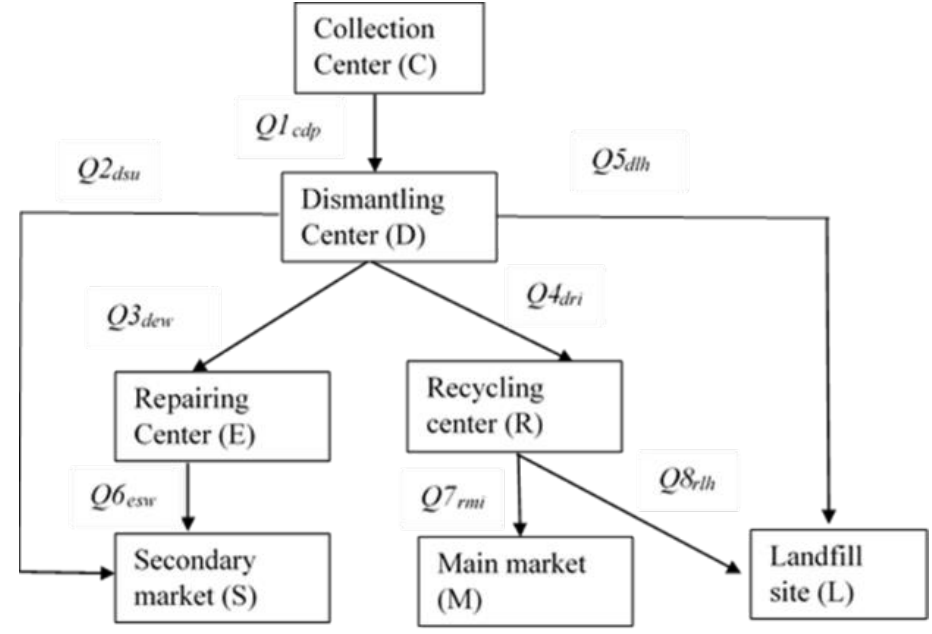
Figure 1. The generic e-waste reverse supply chain (RSC) network.